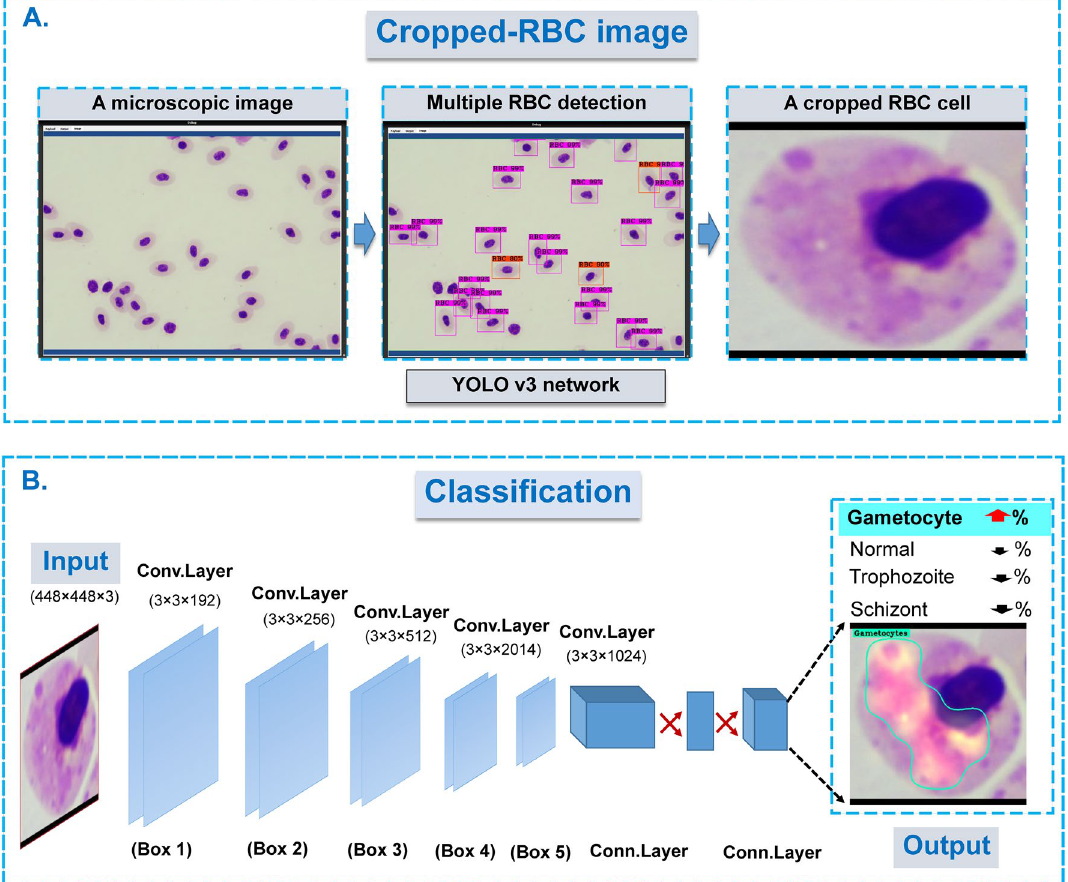
Figure 1. The schematic of the two-state learning strategies for classification of the single chicken’s RBC infected by P. gallinaceum . ( A ) A microscopic image with multiple RBC infected malaria stages was captured under oil immersion field (×1000 magnification). An individual RBCs were cropped under CiRA CORE platform if these cells were correctly detected by well-trained YOLO v3 model. ( B ) Each cropped-RBC cell with/without malaria infection was then classified by trained image classification networks including Darknet, Darknet19, Darknet19-448 and Densenet201, respectively. In the extracting hierarchical features, feature (attention) maps was generated by filters of each convolution layer (within the feature extractor part) and used for visualization through channel-wise averaged gradients. The attention map of the JET color gradient is used to visualize self-region of the interest of the input based on optimal weight. [the figure is drawn by Microsoft PowerPoint. https:// www. micro soft. com/ en- us/ micro soft- 365/ power